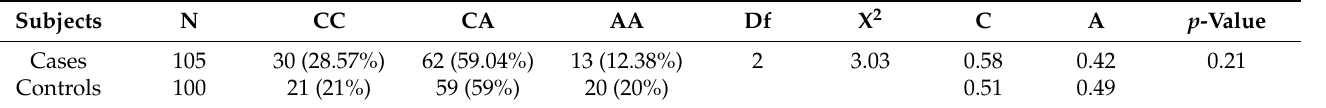
Table 7. Association of miR-423 rs6505162 C > A gene variation in PCOS cases and